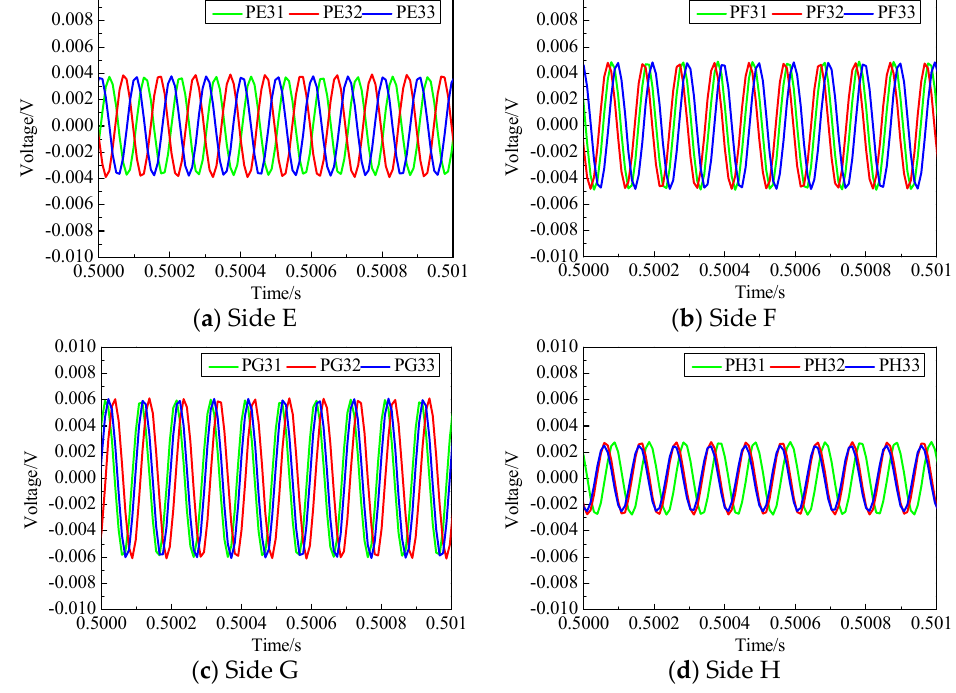
Figure 9. Voltage measurement of the surface-mounted PZT sensors in specimen No. 2.